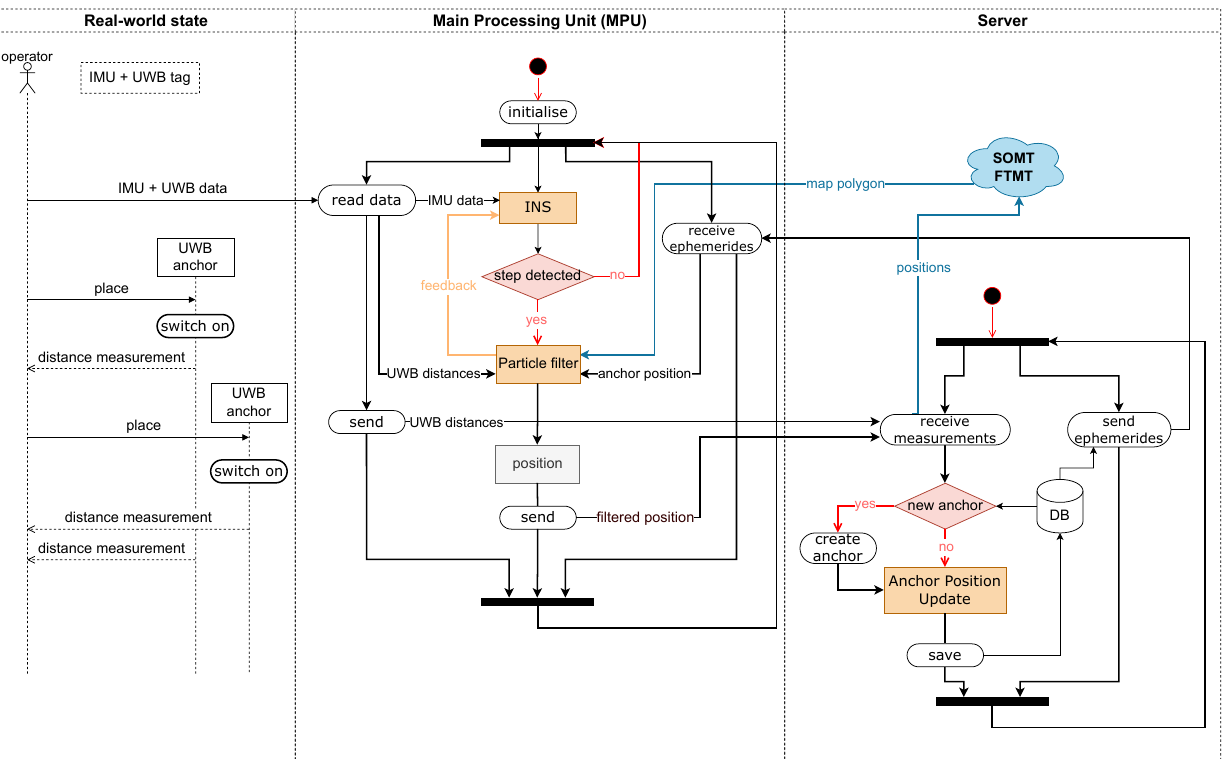
Figure 3. The overall system